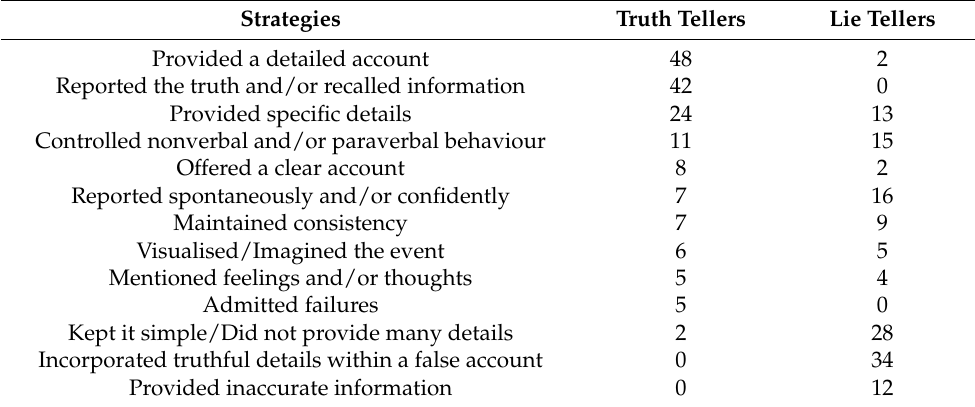
Table 2. Frequency of Convincing Strategies as Reported by Truth Tellers and Lie